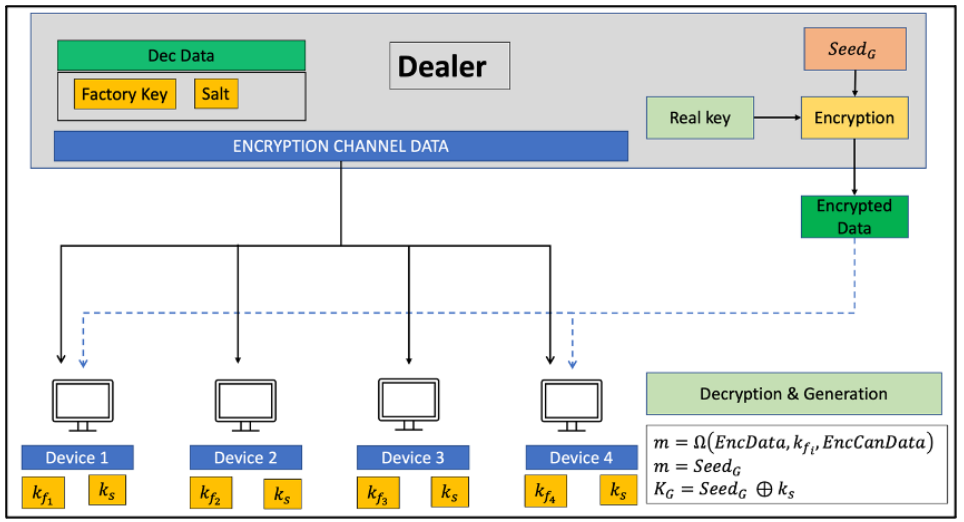
Figure 3. Group Key Generation Phase.